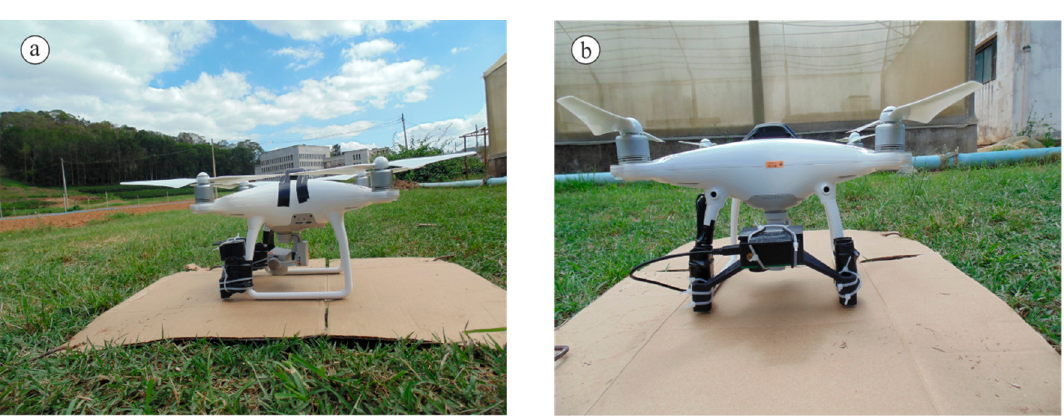
Figure 2. Unmanned aerial vehicle (UAV) used for conducting the study: ( a ) lateral view of the aircraft; ( b ) front view of the aircraft highlighting the Mapir Survey 3 sensor.